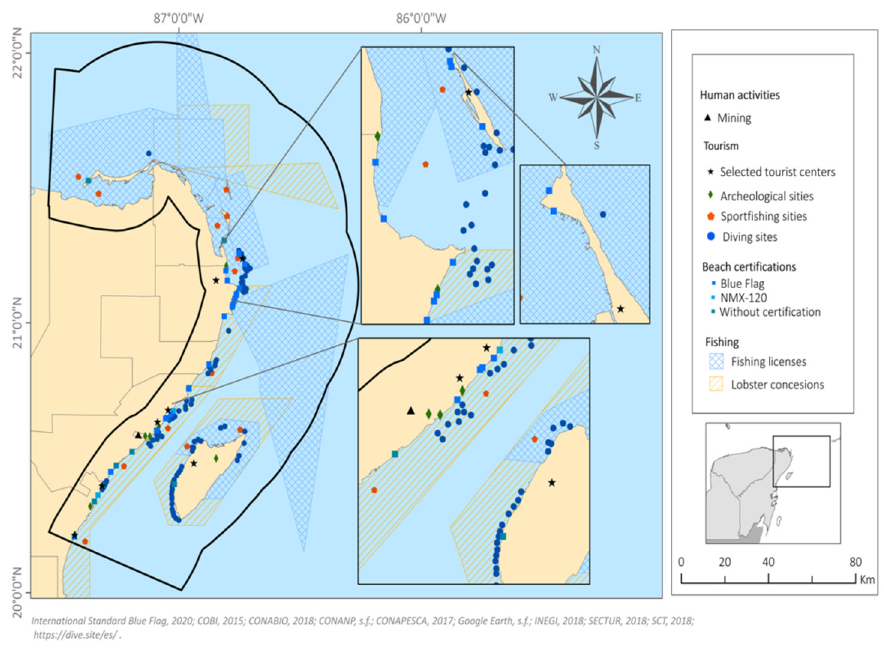
Figure 6. Areas of environmental importance .